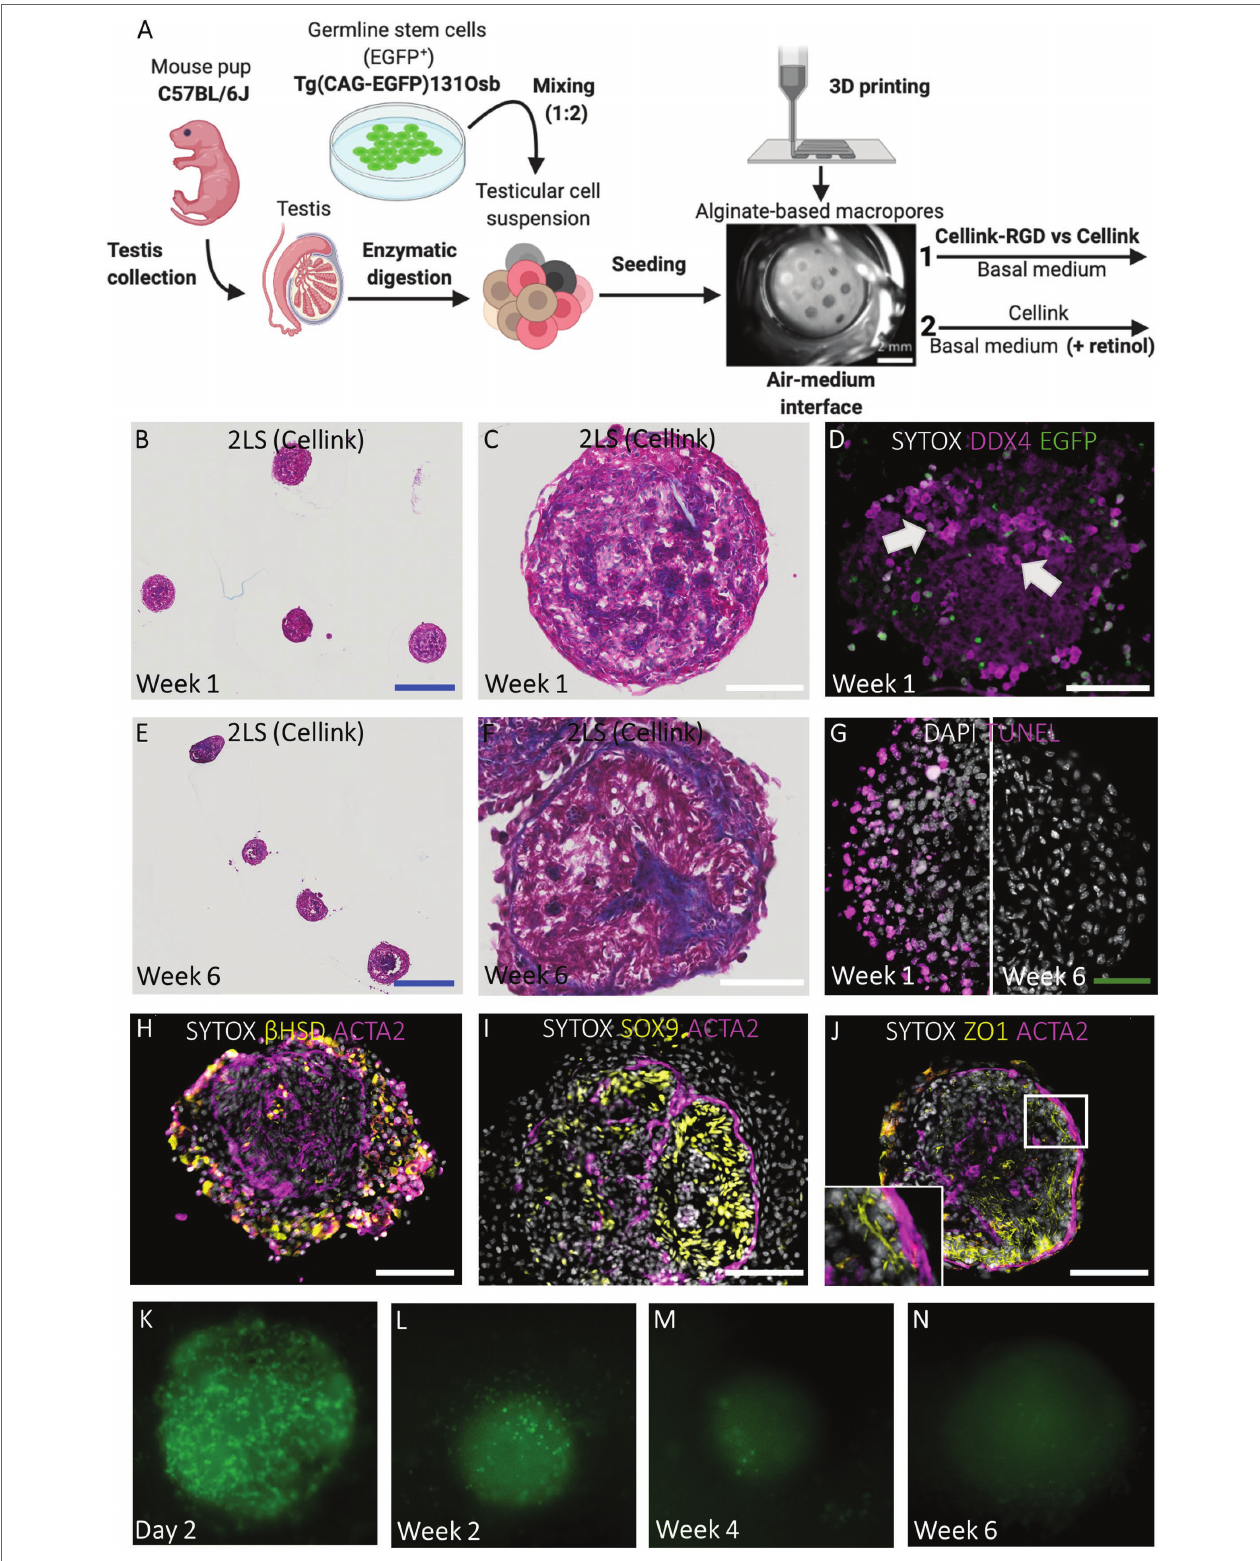
FIGURE 4 | Chimeric TOs in regular 2LSs display uniform morphology and restore components of the SSC niche but show germ cell loss. (A) Schematic representation of experimental procedure. First, modified Cellink-RGD and regular Cellink were compared for their ability to immobilize reorganizing chimeric